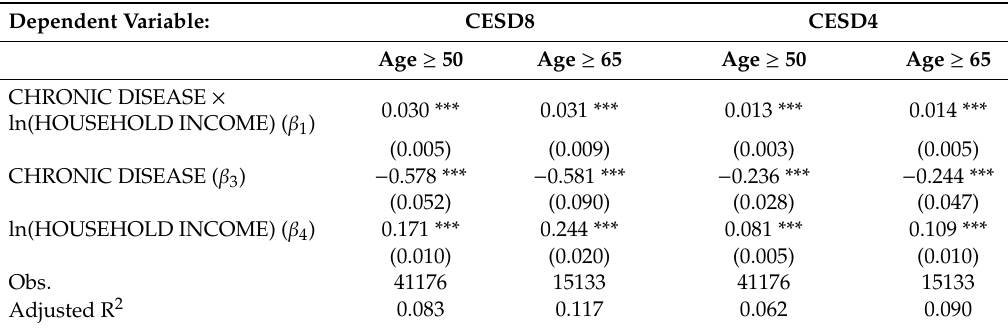
Table 12. Utility proxies.